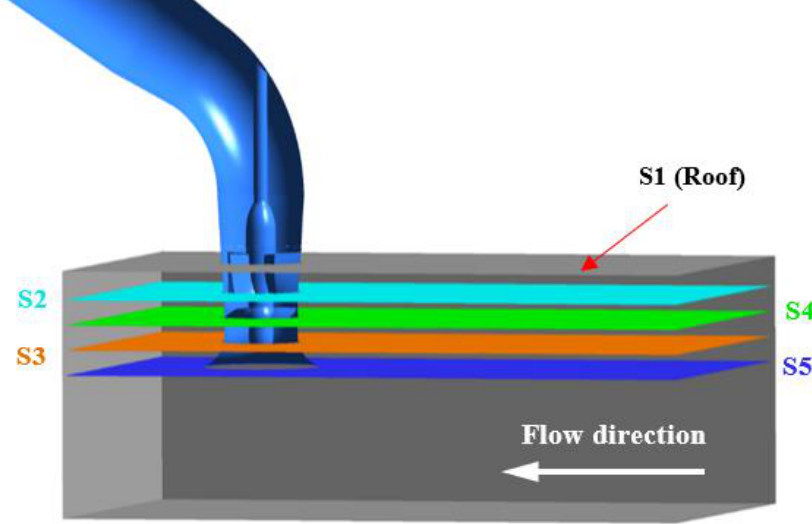
Figure 15. Five axial section positions.